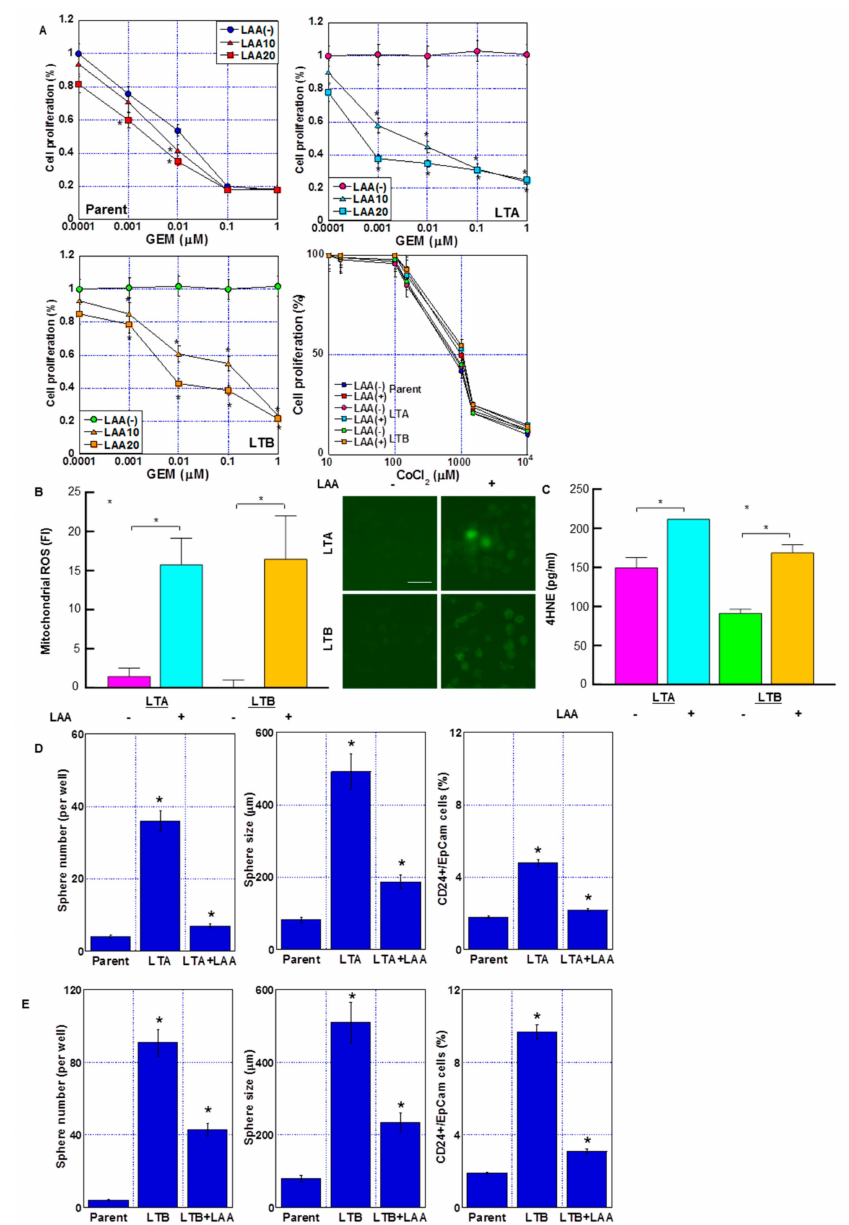
Figure 7. Effect of LAA on GEM sensitivity in GEM-resistant PDA cells. ( A ) Effect of LAA on cell proliferation. Cells were treated with GEM for 72 h with or without LAA (10 and 20 µ g/mL). Effect of CoCl 2 and/or LAA (20 µ g/mL) on cell proliferation was also examined. ( B ) Effect of LAA on ROS production. (Right) Fluorescence images of DHR. Scale bar, 50 µ m. ( C ) 4-HNE levels measured by ELISA. Error bars indicate standard error from three trials. Statistical significance was calculated using Student’s t -test. ( D , E ) Stemness of the GEM-resistant PDA cells. Sphere formation in ( D ) LTA and ( E ) LTB cells was assayed, wherein 10,000 cells were treated with or without LAA for 3 days. (Left) Number of spheres. (Middle) Sphere size. (Right) CD24+/EpCam+ cell population by flow cytometric analysis. ( A – E ) Cells were cultured without GEM and/or CoCl 2 treatment. Error bars indicate standard error from three trials. * p < 0.05. ( A ) vs. LAA(-), ( D , E ) vs. Parent. Statistical significance was calculated using ordinary analysis of variance. GEM, gemcitabine; PDA, pancreatic ductal adenocarcinoma; LTA, MIA PaCa-2 long treatment A; LTB, MIA PaCa-2 long treatment B; LAA, lauric acid; ROS, reactive oxygen species; DHR, dihydrorhodamine 123; FI, fluorescent intensity; ELISA, enzyme-linked immunosorbent